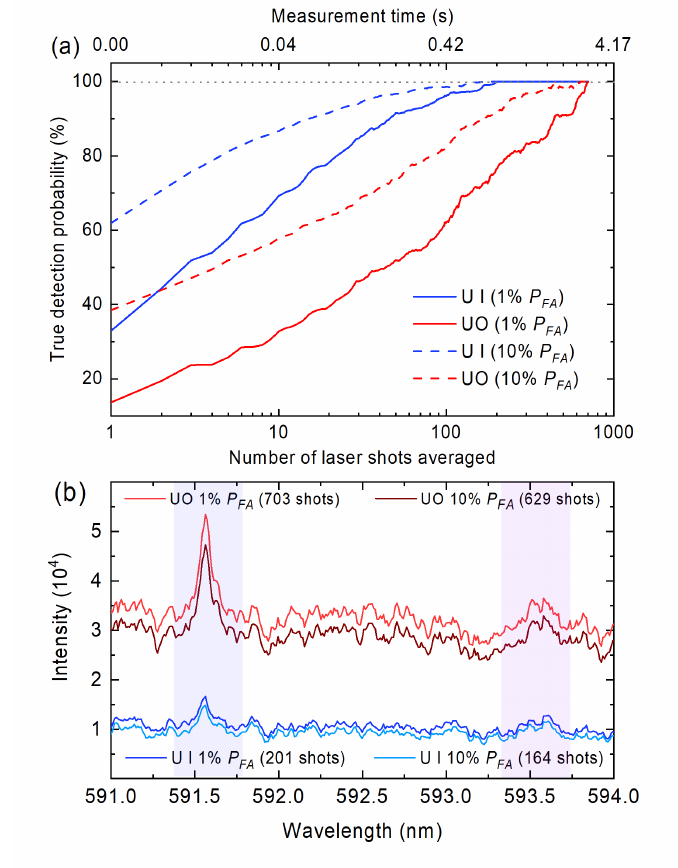
Figure 8. ( a ) Detection probabilities of U I and UO signal features with false alarm rates of 10% and 1%, respectively. ( b ) The spectra which result from averaging these numbers of shots for unity detection probability with fixed false alarm